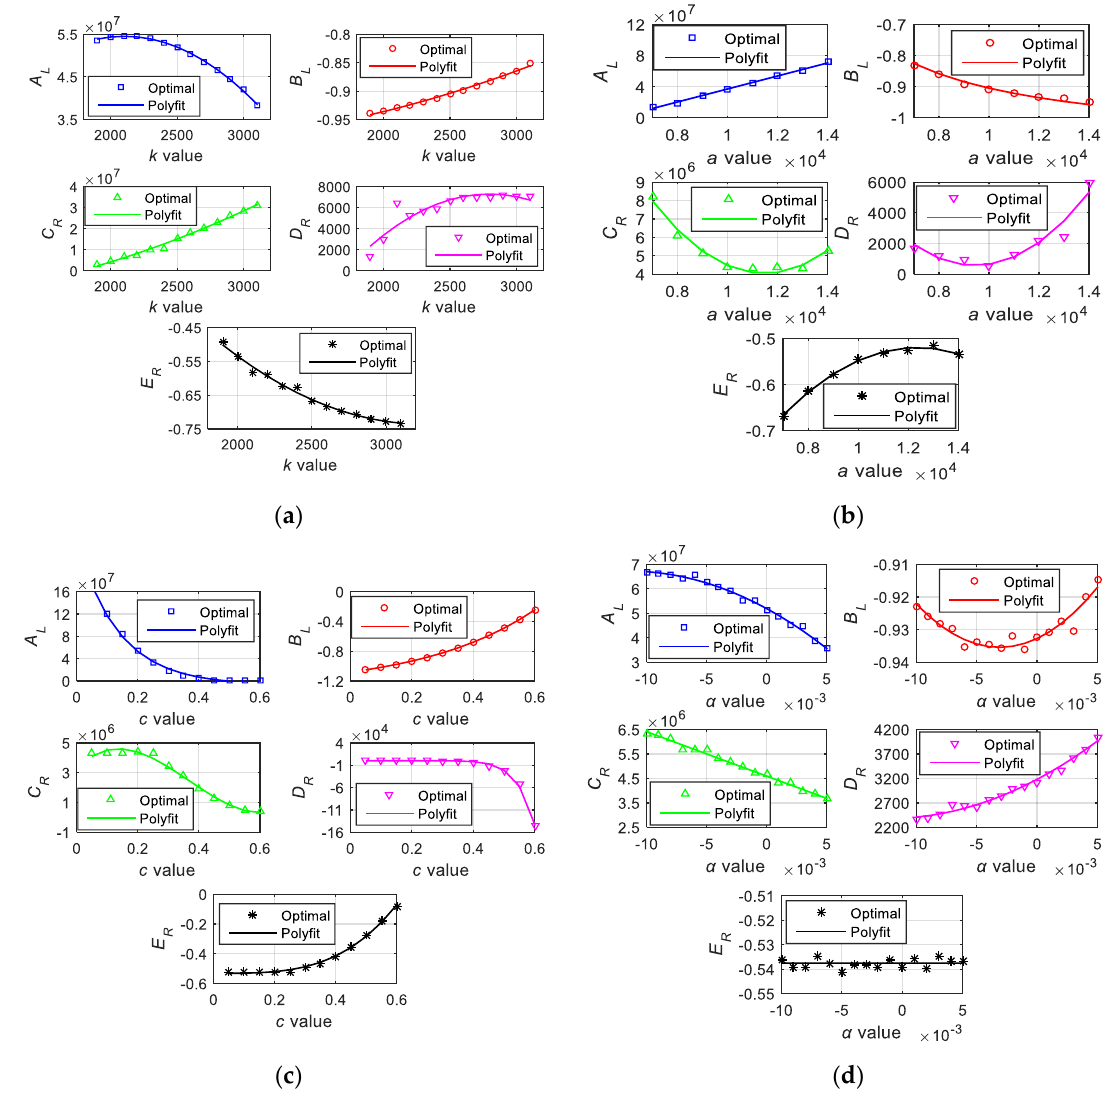
Figure A2. Optimal and fitted values of the parameters under univariate analysis. ( a ) take k as independent variable; ( b ) take a as independent variable; ( c ) take c as independent variable; ( d ) take α as independent variable.